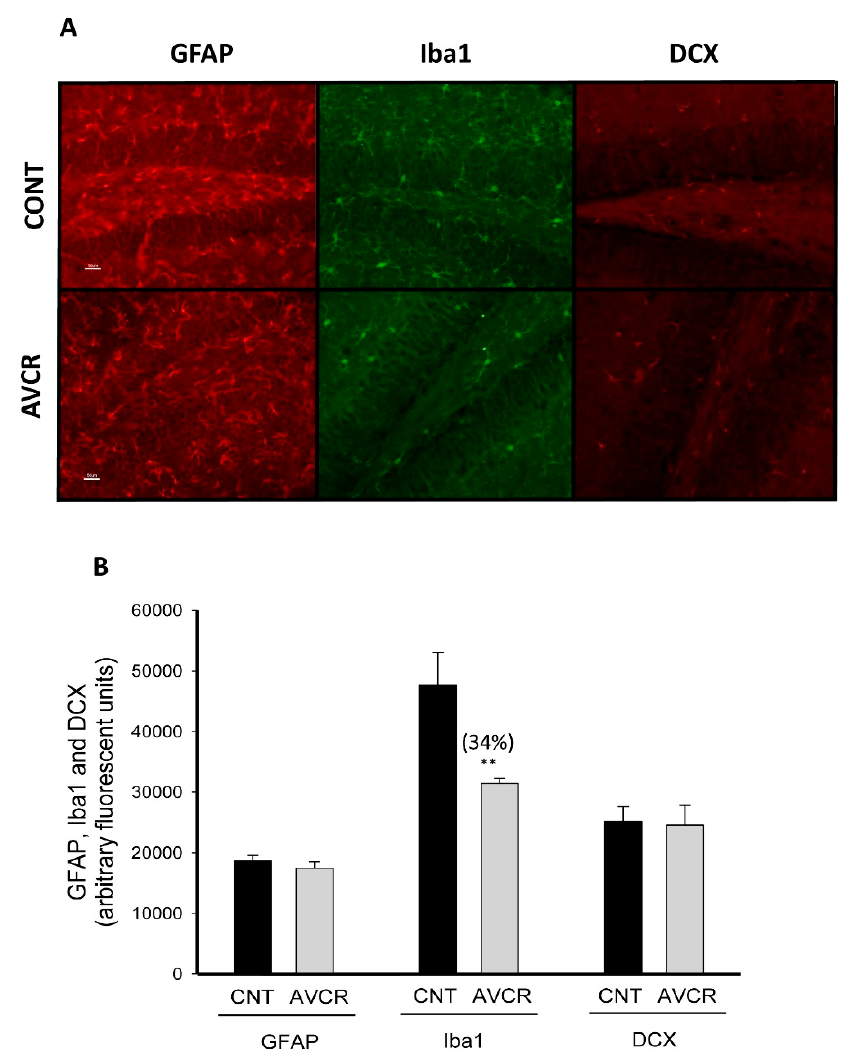
Figure 6. Effect of AVCRI104P3 on GFAP, Iba1 and DCX in the hippocampus (dentate gyrus, DG) of 12-month-old 129/Sv × C57BL/6 male mice. ( A ) Representative images of immunohistochemical studies for GFAP, Iba1 and DXC. Scale bar: 50 µm. ( B ) Semi-quantitative analysis of optical density using the free Image J 1.49 programme. Each point is the mean ± S.E.M. (% of arbitrary fluorescent units) of 3–4 animals and each experiment ( n = 3) was carried out at least in triplicate. The statistical analysis used was the Student t test for each antibody; ** p < 0.01 vs. CNT.